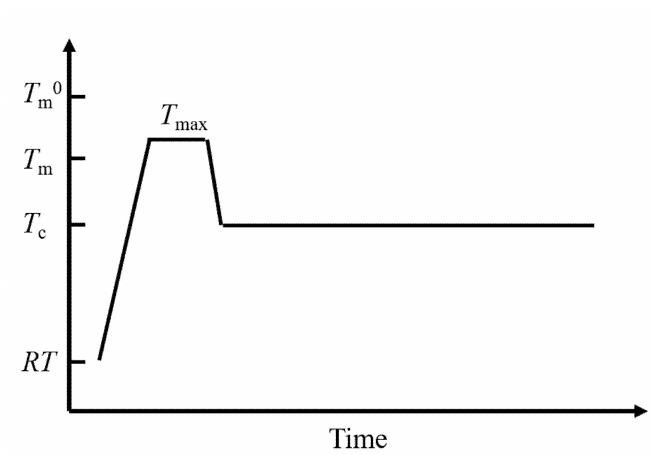
Figure 11. Typical thermal history necessary for the magnetic alignment of crystalline